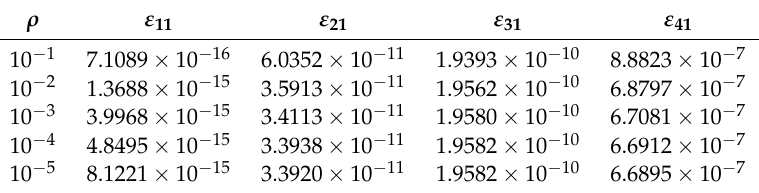
Table 4. ε 12 , ε 32 together with their upper bounds ε 22 , ε 42 of Example